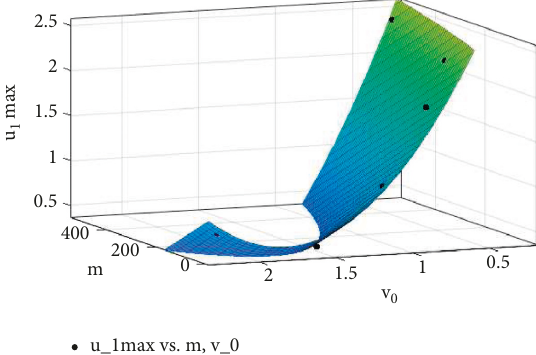
Figure 16: Relationship between (m) v0, and